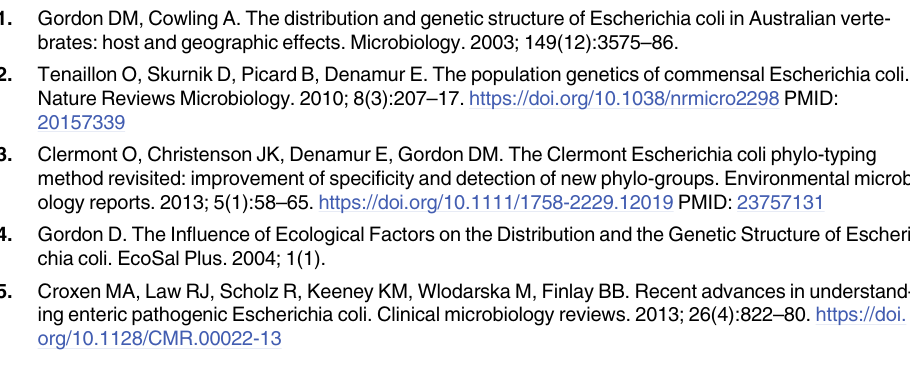
S1 Table. Host metadata and REP type designation, phylogroup, human-associated ST, and antimicrobial susceptibility profile for all Escherichia coli